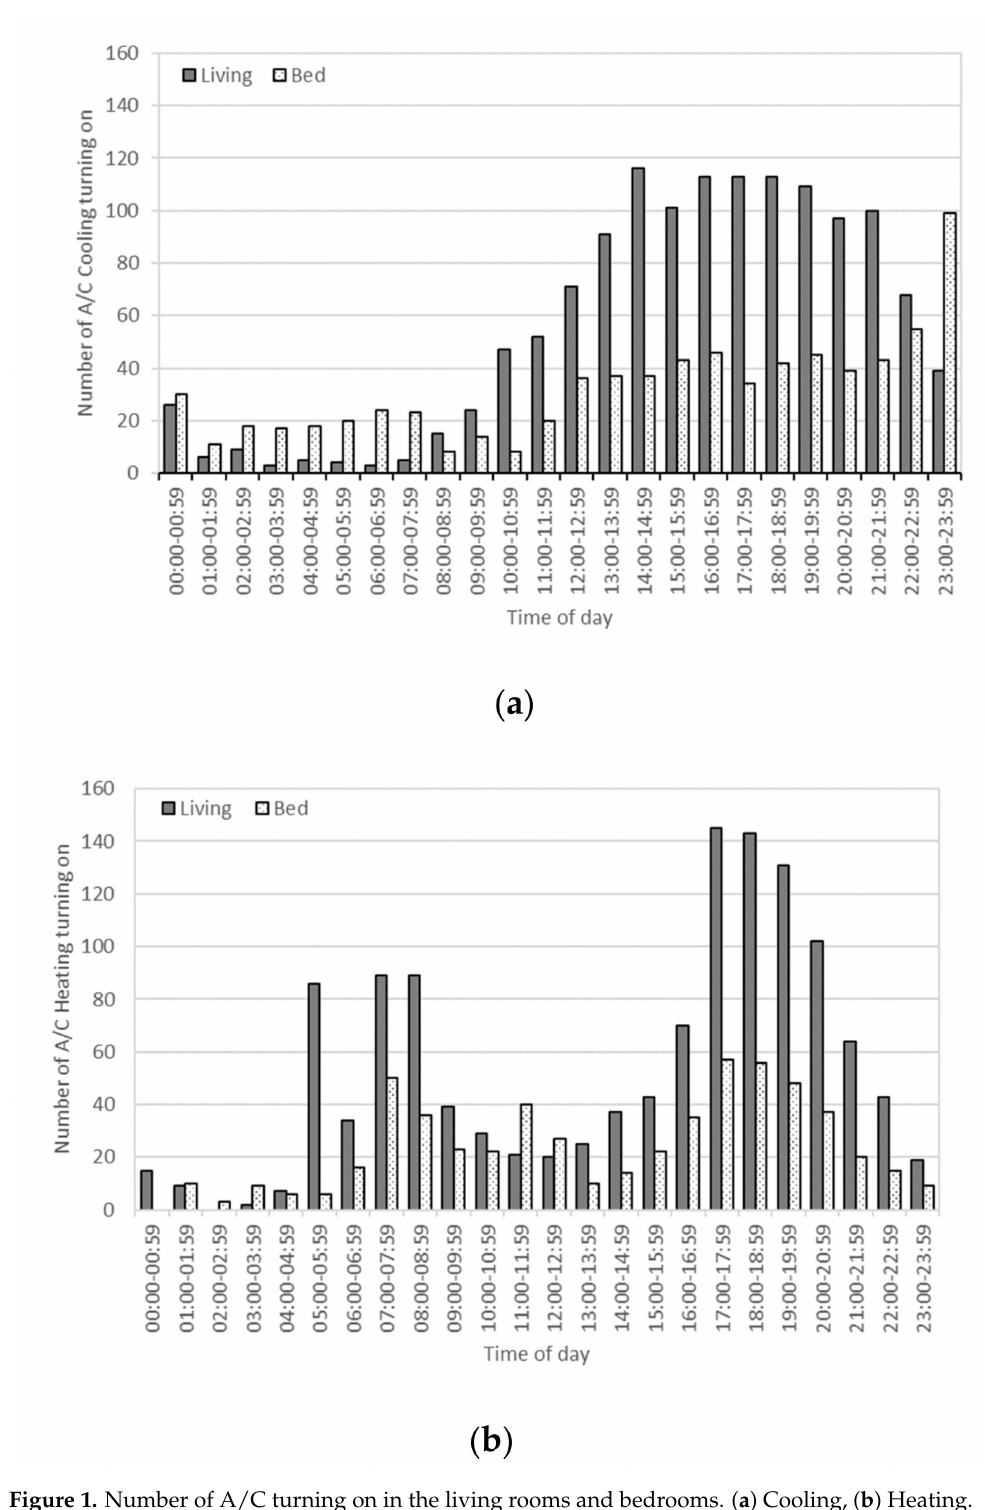
Figure 1. Number of A/C turning on in the living rooms and bedrooms. ( a ) Cooling, ( b )